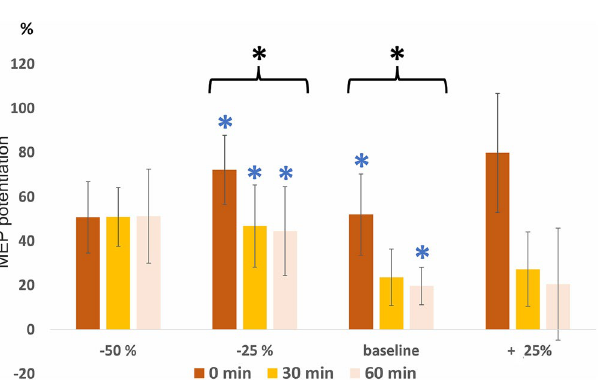
Figure 3. Results of Experiment 2. The data is presented as mean ± standard error. Motor evoked potential (MEP) potentiation is visualized as % post paired associative stimulation (PAS) of pre-PAS minus 100% (everywhere else in the manuscript, all results are presented as % post-PAS of pre-PAS without subtracting 100%). Baseline intensity means minimal intensity required to produce 1/10 F-response persistence. Considering all time points as a group, PAS produced statistically significant MEP potentiation (black stars) with peripheral nerve stimulation (PNS) intensity of “baseline” and “baseline − 25%” levels (p = 0.033 and p = 0.018 by Friedman test, respectively), but not with PNS intensity of + 25% and − 50% levels. Within the “baseline” group (blue stars), there was a significant MEP potentiation at 0 min and 60 min (p = 0.009 and 0.041 by Wilcoxon signed-rank test, respectively). Within − 25 level results (blue stars), there was significant MEP potentiation at all time points (p = 0.007, 0.037, 0.041, at 0, 30, and 60 min, respectively, by Wilcoxon signed-rank